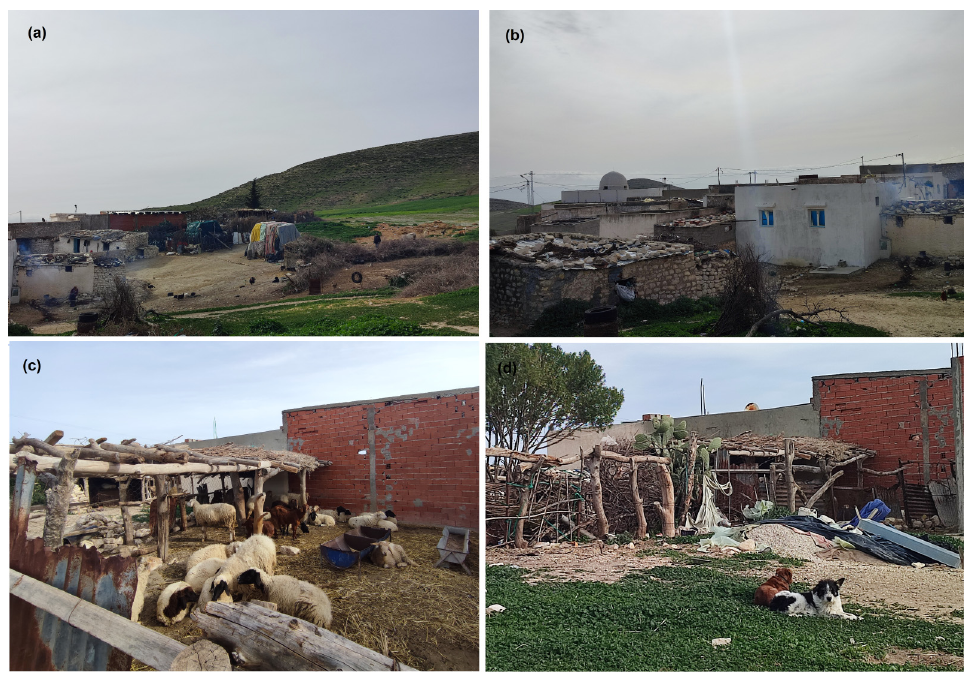
Figure 2. Photographs showing landscape and habitats in the sampling site of Djema. ( a ) Global view of the site: a rural zone surrounded of hills and cultivated fields. ( b ) Location of houses in relation to each other. ( c ) Animal shelter with domestic animals close to houses. ( d ) Dogs around houses and animal shelters. Sandflies were collected using CDC miniature light traps equipped with a fine net cage (John W. Hock Company, Florida, USA) during two successive entomological sea-